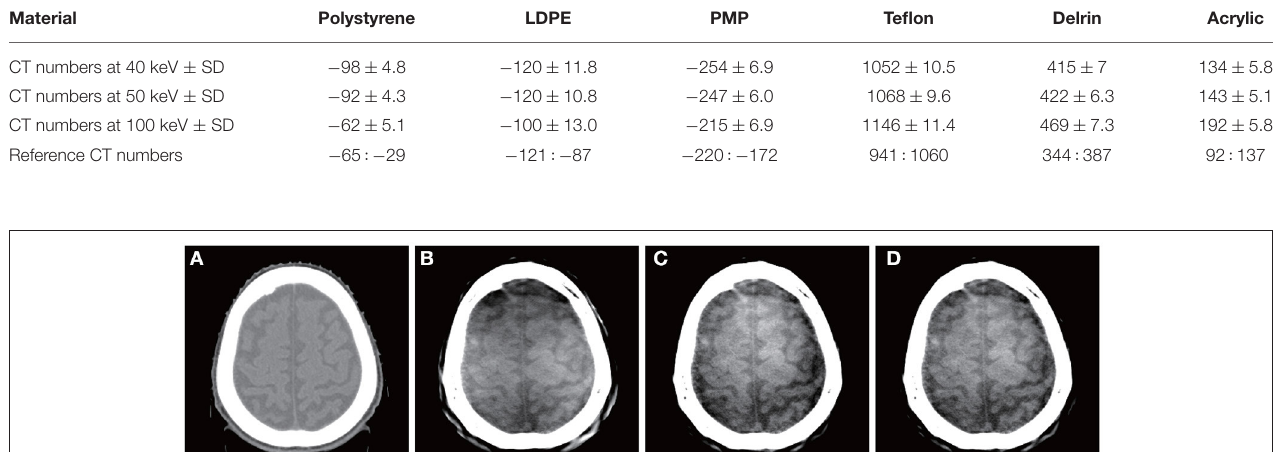
TABLE 1 | CT numbers reconstructed for materials in Catphan 504 (Unit: HU).